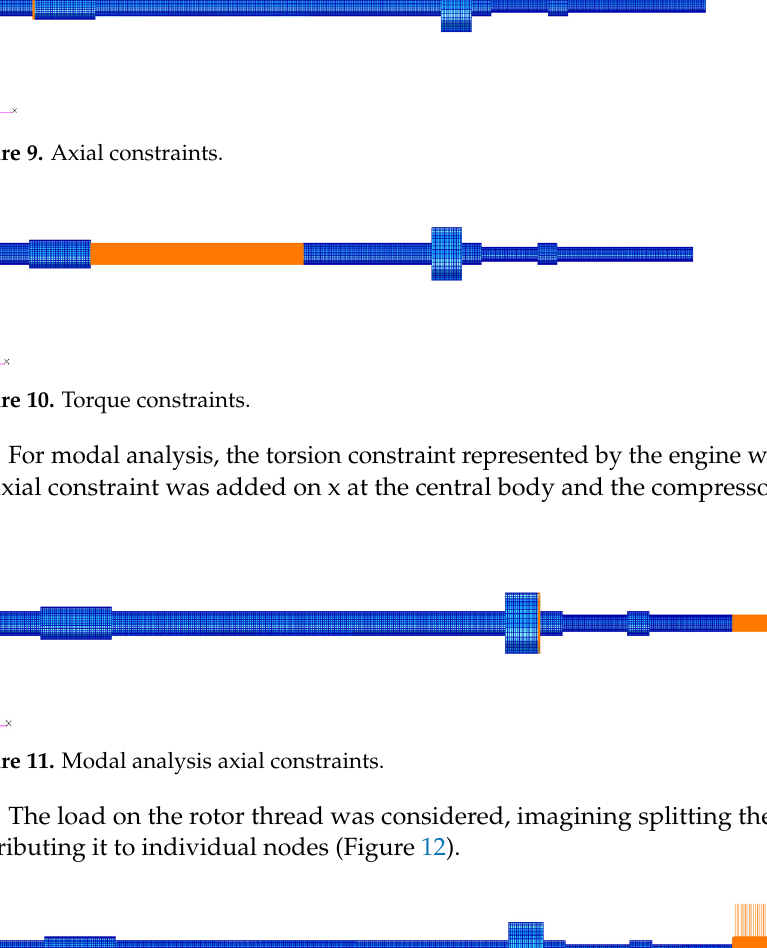
Table 5. Rotor load characteristics.